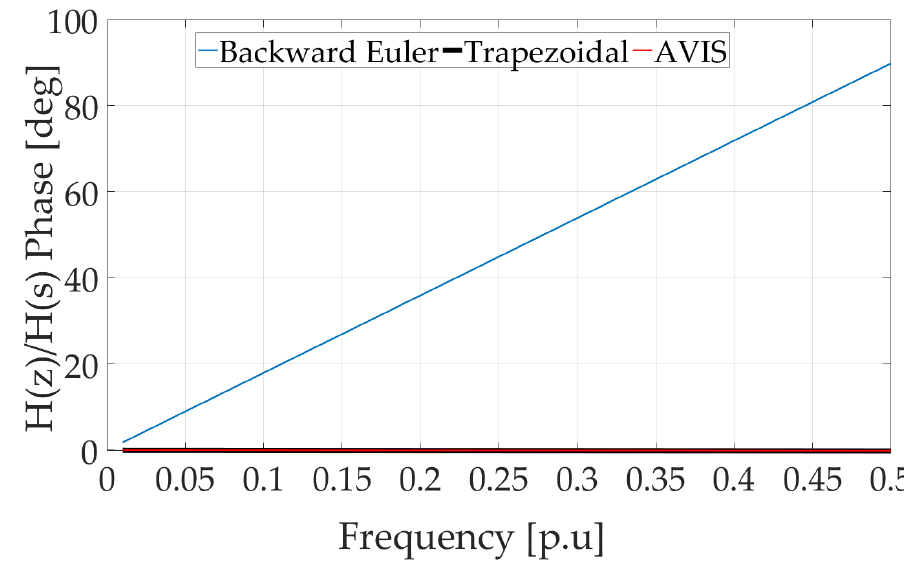
Figure 4. Phase frequency response of transmittance for considered numerical